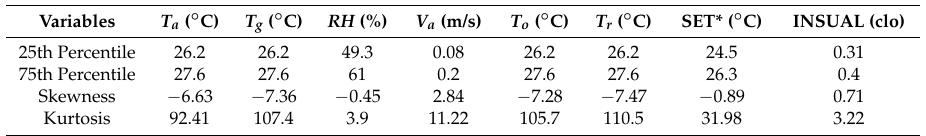
Table 3. The distribution of thermal